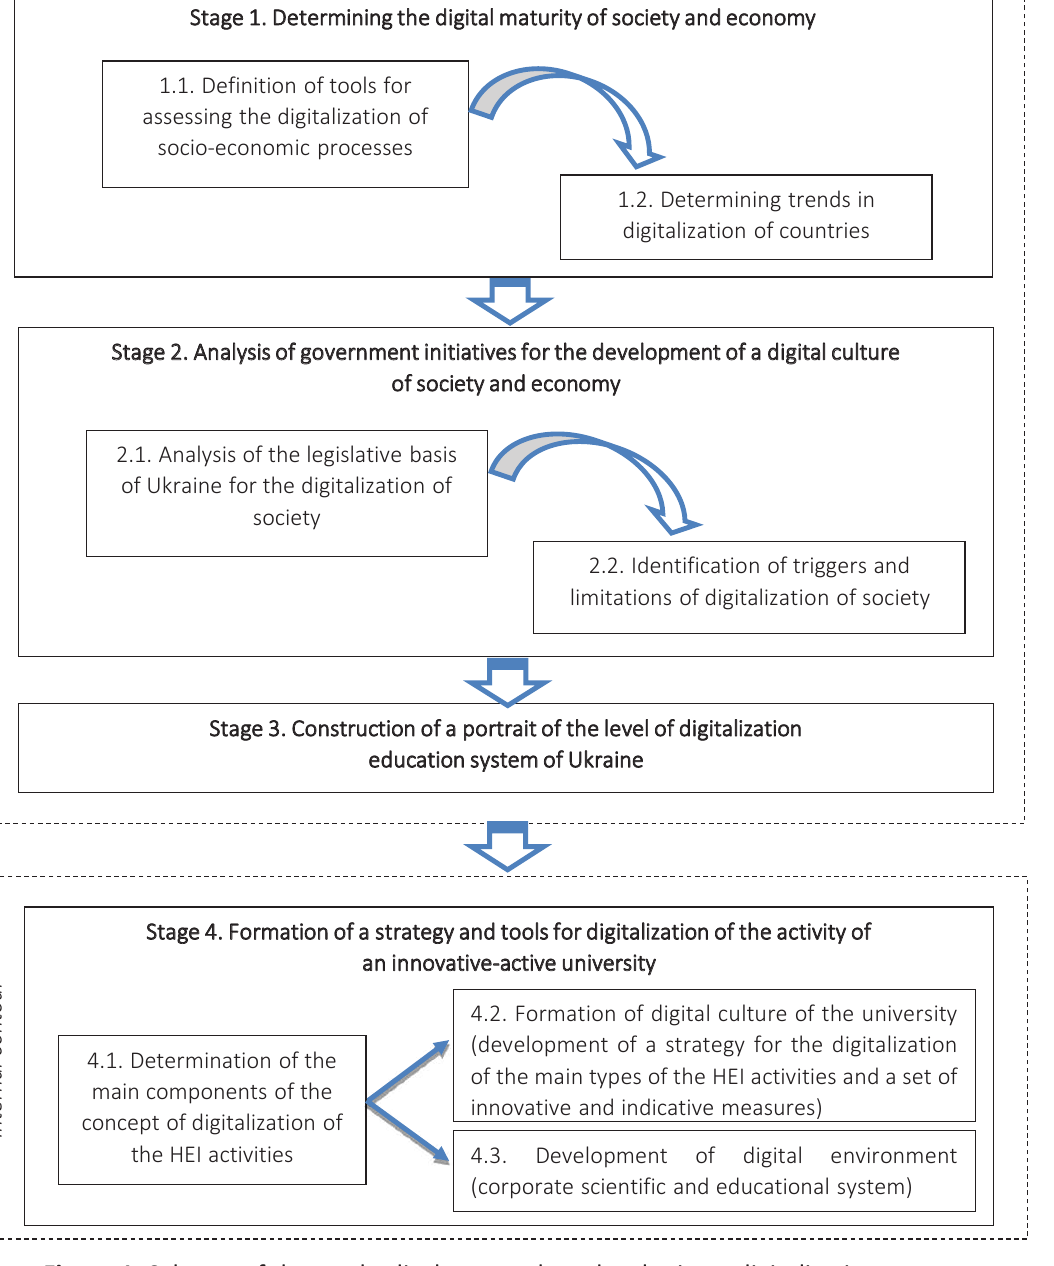
Figure 1. Scheme of the methodical approach to developing a digitalization strategy for the spheres of university